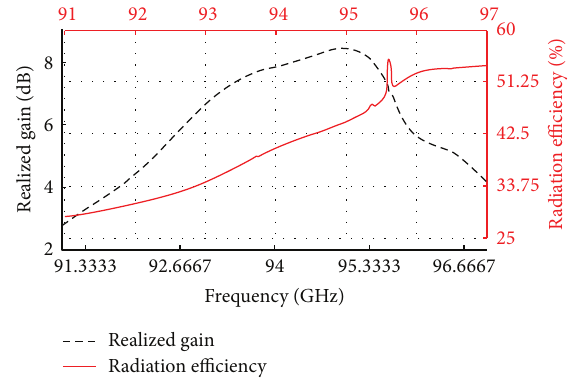
Figure 8: Antenna gain and efficiency, with 𝐿 1 = 14mm, 𝑊 1 = 10mm, 𝐿 2 =11.68mm, 𝑊 2 =5.82 mm, 𝑆 off =0.06 mm, 𝐶 𝐿 =1mm, 𝐶 = 13 𝜇 m, 𝑊 = 0.19mm, 𝐺 = 20 𝜇 m, 𝐿 𝑠 = 0.75 mm, 𝑊 𝑠 = 0.103 mm, 𝐿 = 0.417 mm, 𝐶 off = 0.16mm, and 𝑃 𝑤 = 0.01 mm. stub